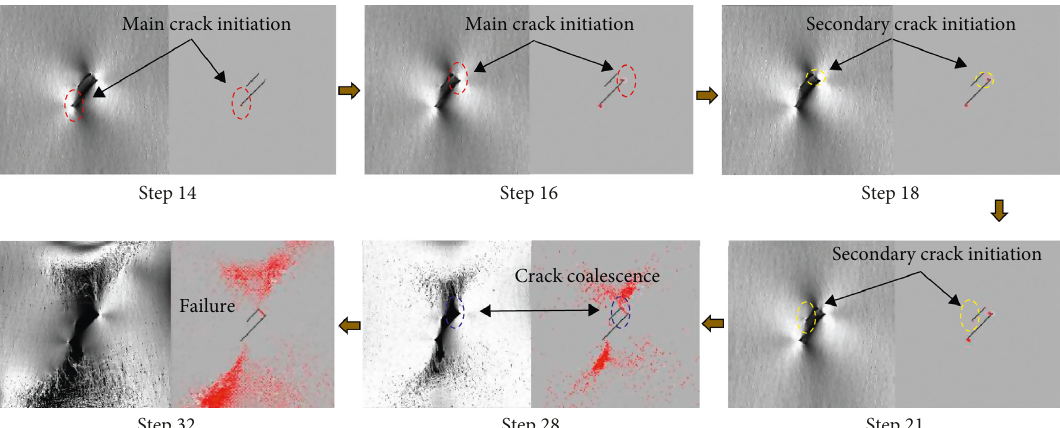
Figure 22: Crack initiation and propagation process in Model 2.